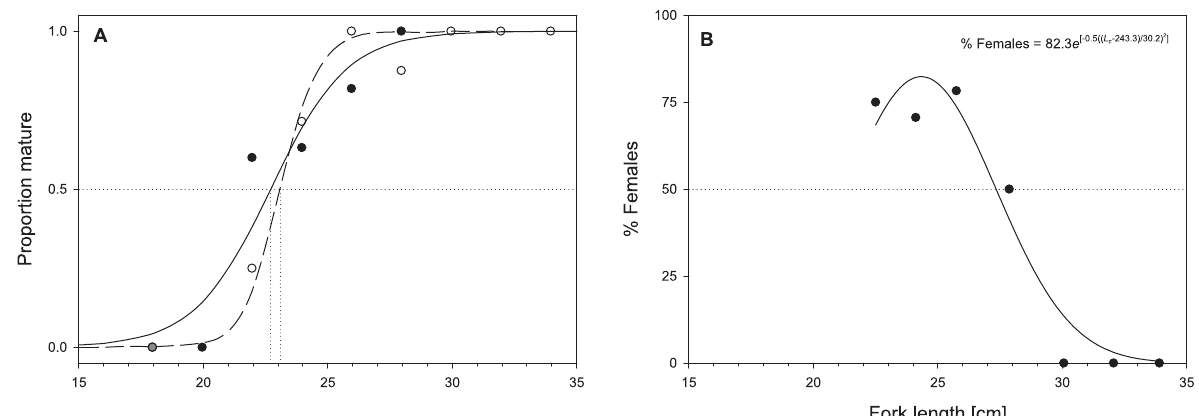
Figure 5. Reproductive information for Parupeneus indicus from Fiji. ( A ) size at maturity ( L relative to all mature individuals, versus length. Females are represented by closed circles and the solid curves, males are represent- ed by open circles and the dashed